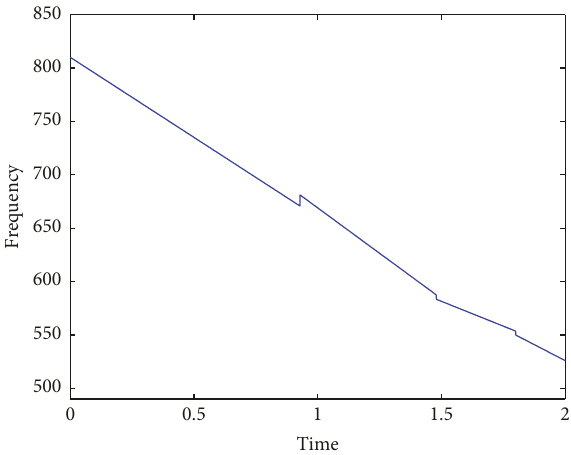
Figure 18: Estimated instantaneous frequency of the signal pre- sented in Figure 16.